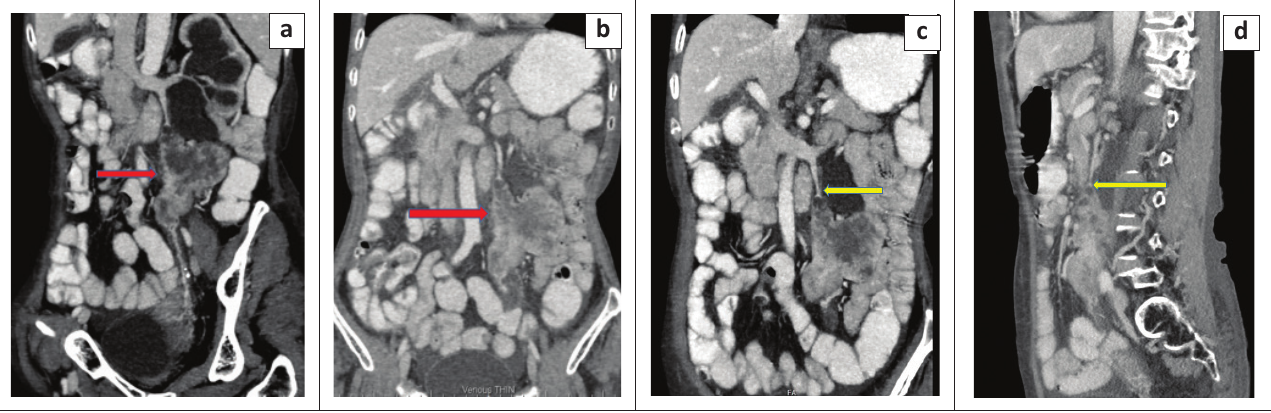
FIGURE 4: Coronal oblique (a), showing a well-defined heterogeneous mass (red arrow) along the course of left gonadal vein causing hydronephrosis and hydroureter. Coronal (b–c) and sagittal (d) reformatted CT abdomen reveal a well defined heterogeneously enhancing retroperitoneal mass (red arrow) along the course of the left gonadal vein causing filling defect (yellow